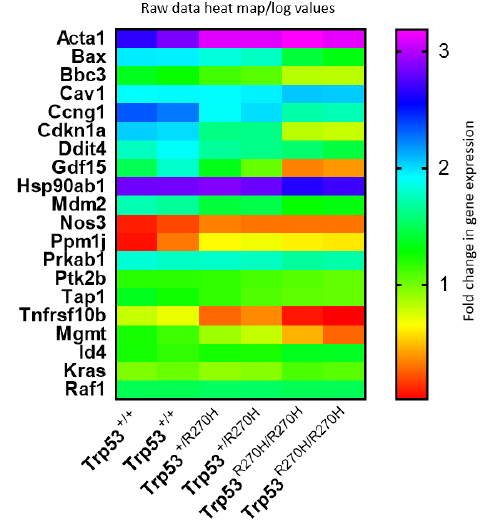
Figure 4. Gene expression heat map. Comparison of gene expression log values between the three genotypes and between differentially genes reveals that gene dosage effects exist for some, but not all genes, and that the relative impact of the p53 R270H mutant on gene expression varies widely between genes. This figure was generated using log transformed raw data for differentially expressed genes. Table 2. The Trp53 R270 mutant allele mediates alterations in expression levels of validated tran- scriptional targets of the Trp53 R270H allele as well as alterations in expression levels of genes asso- ciated with incidence of prostate cancer in patients. Two known transcriptional targets of Trp53 R270H , Mgmt and Id4 , demonstrated differential expression in wildtype ( Trp53 +/+ ) versus hetero- zygous ( Trp53 +/R270H ) and/or or homozygous mice ( Trp53 R270H/R270H ). A dose-dependent effect was ob- served for Mgmt . The expression of 4 genes which are associated with prostate cancer incidence and/or disease progression ( Cdkn1a , Kras , Raf1 , and Cav1 ) were impacted by the presence of the Trp53 R270H allele. A gene dosage effect was observed for 1 of these, Cdkn1a . Data shown are fragments per kilobase of exon model per million mapped reads (FPKM).